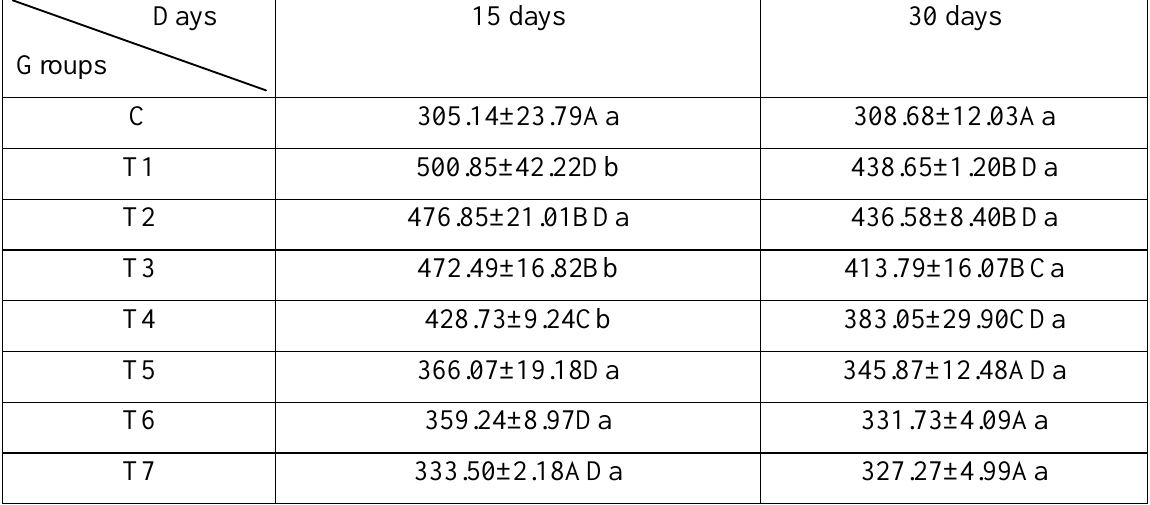
- LSD=42.515. - C= control. -T1= Animal Injected iron dextran 100 mg/kg B.W + Polyphenol 75 mg/kg.